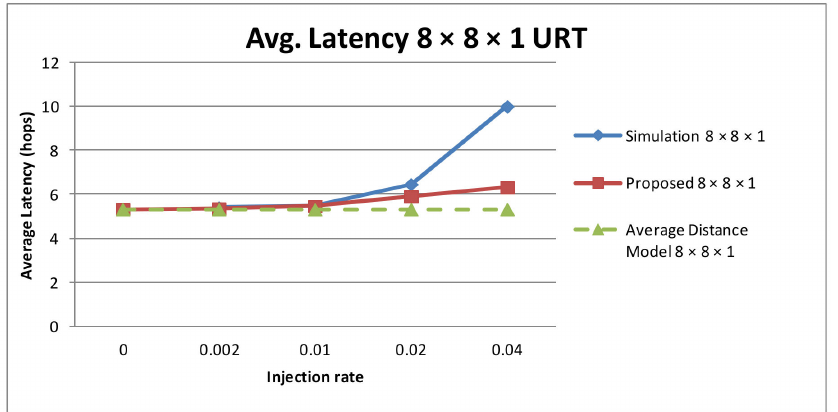
Figure 7. Average estimated latency vs. flit injection rate comparison between simulation, the proposed model and the average distance model for 8 × 8 × 1 topology and uniform random